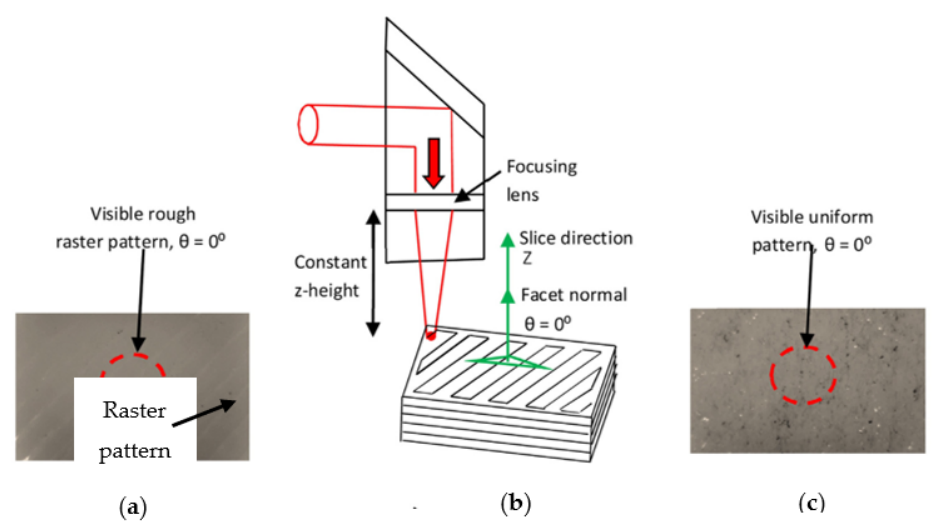
Figure 15. The result of laser polishing the ABS part at a build orientation angle θ = 0°: ( a ) raster pattern before laser polishing; ( b ) schematic of laser polishing; ( c ) laser polished surface [36].